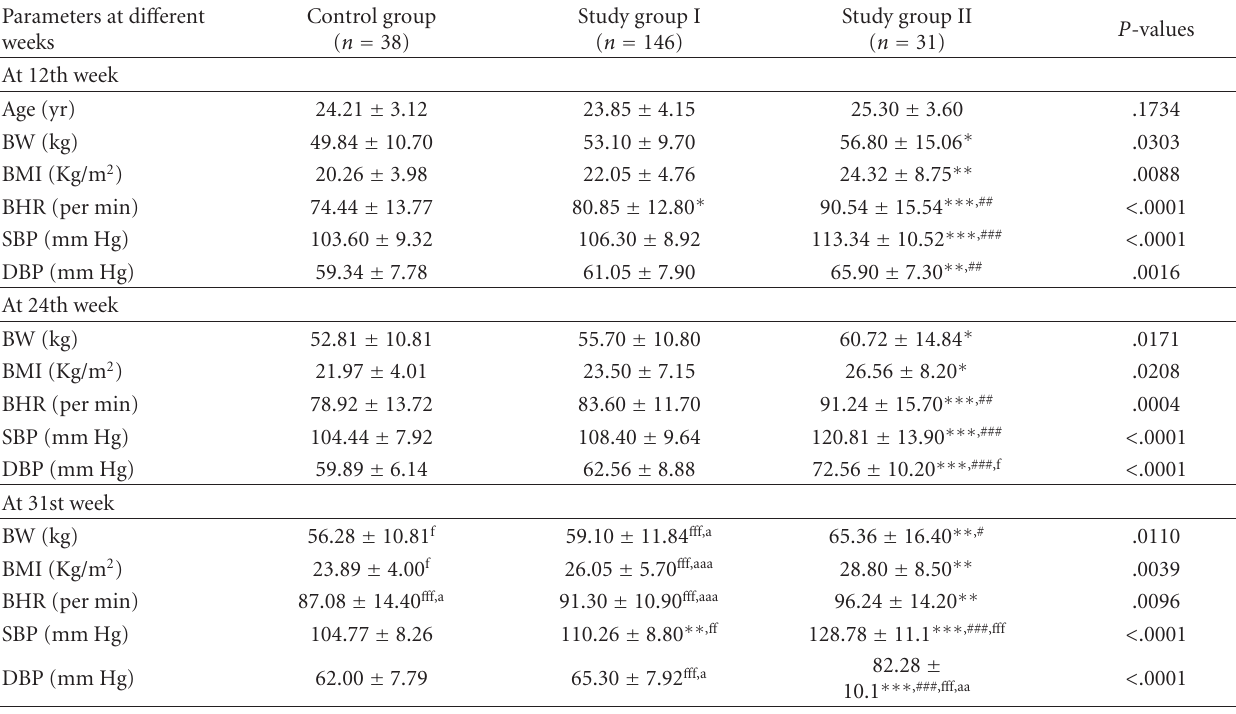
Table 1: Comparison of age, body weight (BW), body mass index (BMI), heart rate (HR), systolic blood pressure (SBP), and diastolic blood pressure (DBP) of the subjects of control group (subjects with normal pregnancy) with the subjects of study group I (those who had high risk for PIH, but did not develop PIH) and study group II (those who developed PIH later) at di ff erent weeks of